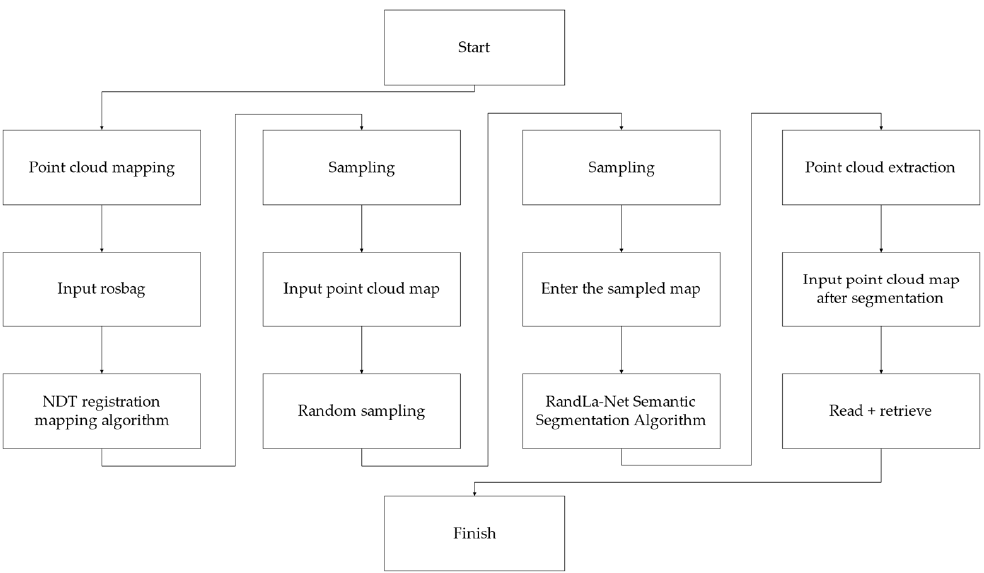
Figure 13. Process of the improved RandLa-Net algorithm.